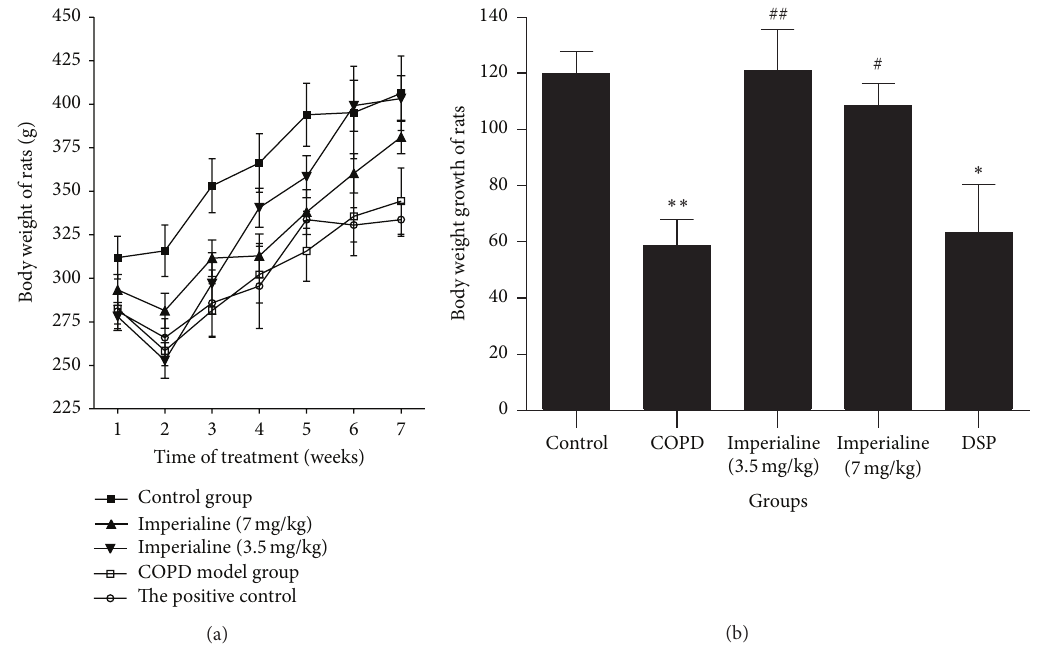
Figure 1: The effect of imperialine on (a) the body weight and (b) body weight growth of rats. Results were expressed as the mean ± SEM ( 𝑛 = 10 ). Significant differences compared with the control group were designated as ∗ 𝑃 < 0.05 and ∗∗ 𝑃 < 0.01 . Significant differences compared with the COPD group were designated as # 𝑃 < 0.05 and ## 𝑃 < 0.01